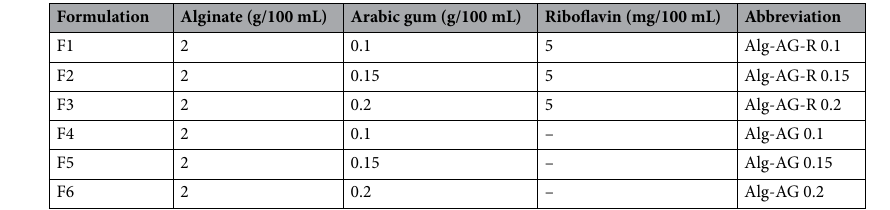
Table 2. Various Alginate- Arabic gum formulations with and without riboflavin.